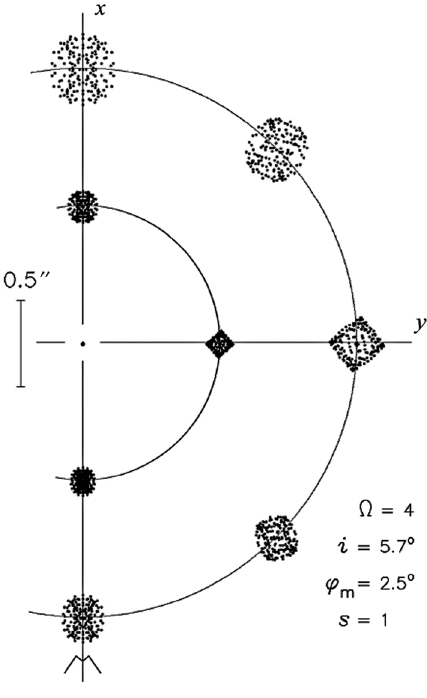
Figure 2: Best residual aberrations of an f /4 two-mirror reflective Schmidt ( Ω = 4) in the non-centered system form. Incli- nation angle i = 5.7°. Semi-FOV φ = 2.5°. The under-correction parameter is just set to s = 1. The radius of curvature of m the spherical focal surface is also given by R = OF in eq. (3). The largest blur image corresponds to that with highest FoV deviation of the